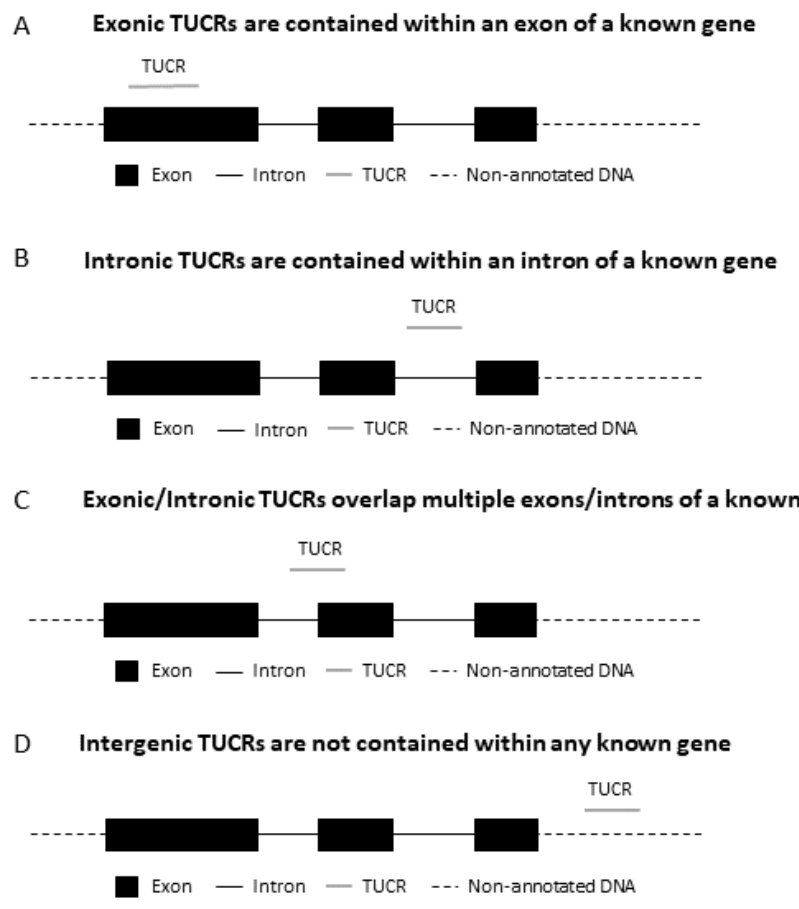
Figure 3. TUCRs can be intragenic or intergenic. Intragenic TUCRs can be found within the exon of their “host gene” ( A ), an intron ( B ), or straddling splice sites as exonic/intronic ( C ). The remainder exist outside of annotated DNA/RNA and are considered to be intergenic ( D ).